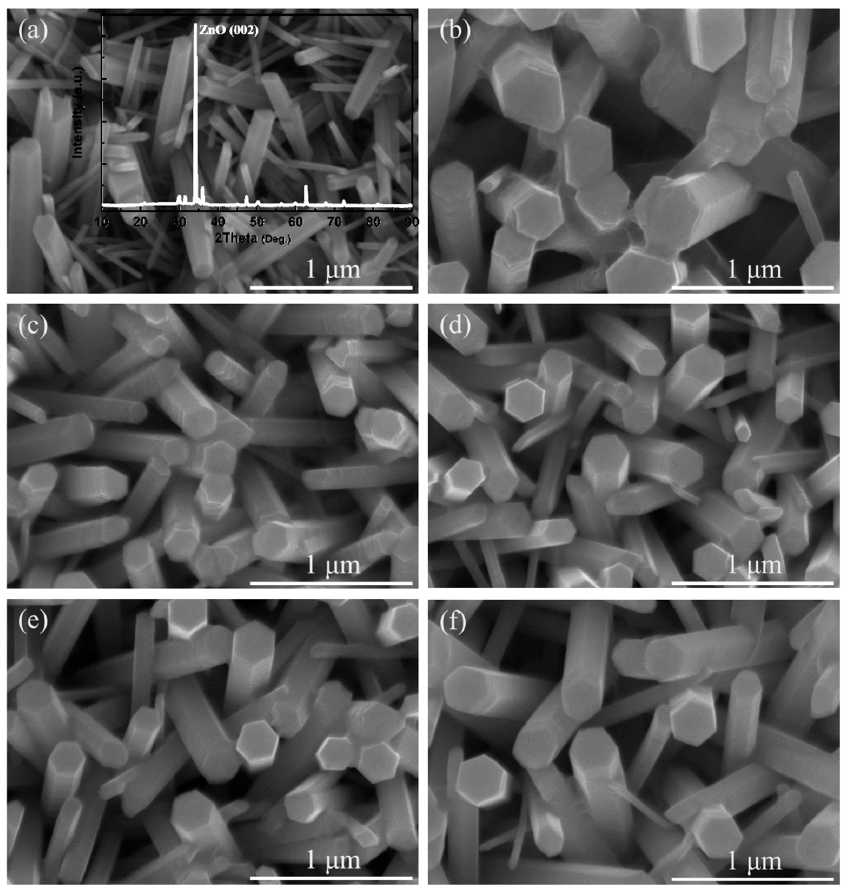
Figure 1. ( a )–( f ) SEM images of ZnO and ZnS/ZnO nanocomposites with different immersion time of 5, 15, 30, 45, and 60 min, respectively.